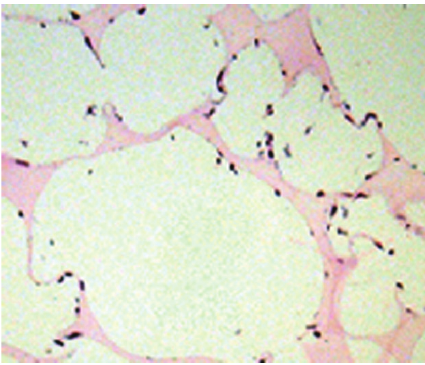
Figure 2: Photomicrograph (100 × ) highlighting the uniform cell distribution within the sca ff old. All pores throughout the sca ff olds have a similar appearance 12 hours after seeding.